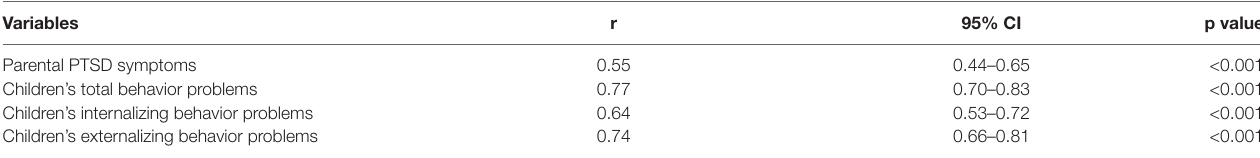
PTSD, post-traumatic stress disorder; r, Pearson’s correlation coefficient; CI, confidence